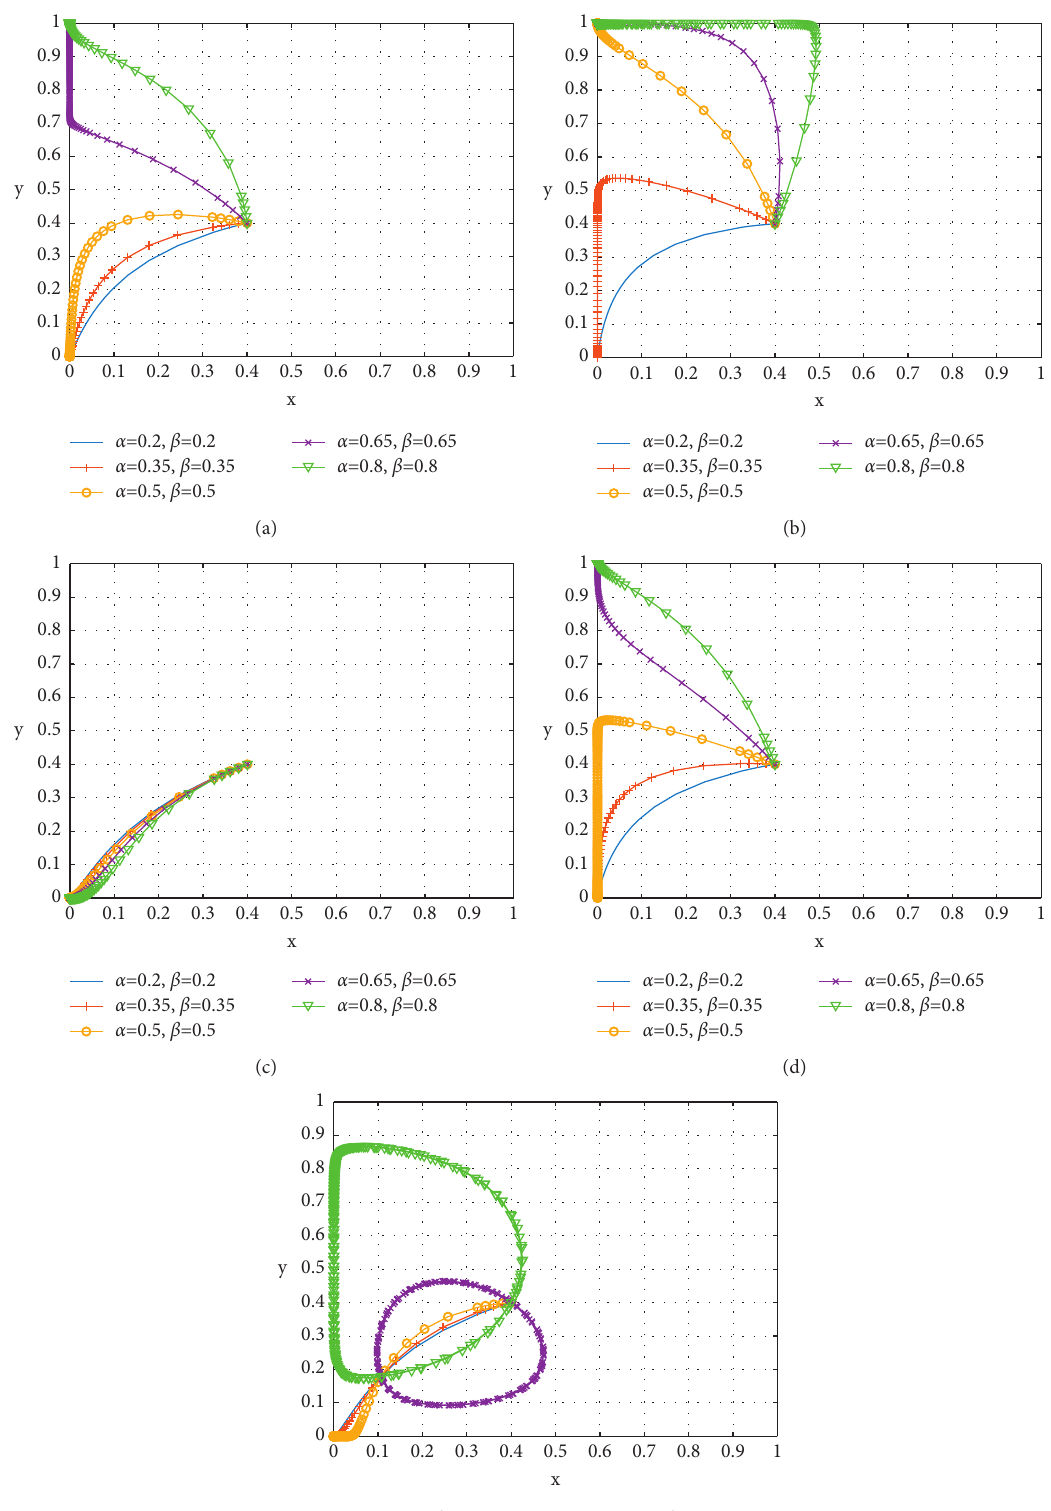
Figure 9: Evolution results with the change of α and β by the initial values in Case 1. (a) A (c) A p � 1 , A s � 1. (d) A p � 1 , A s � − 1. (e) A p � − 1 , A s �